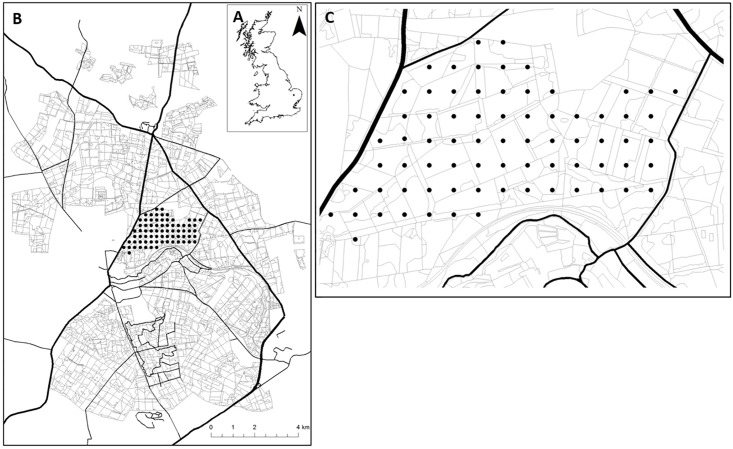
A) United Kingdom coastline. Thetford Forest (black dot) is situated in East Anglia. B) Map of the main central Thetford Forest block. Thick dark lines indicate busy A-roads. Thinner dark lines indicate minor roads. Black dots represent study grid. C) Study grid. Dots represent sampling points (n = 73), which are spaced 250m apart. Polygons represent different forest stands. The thick dark line on the Western edge of the grid is the A1065 and the thick dark line to the North East of the Grid is the A134 –two busy main roads.